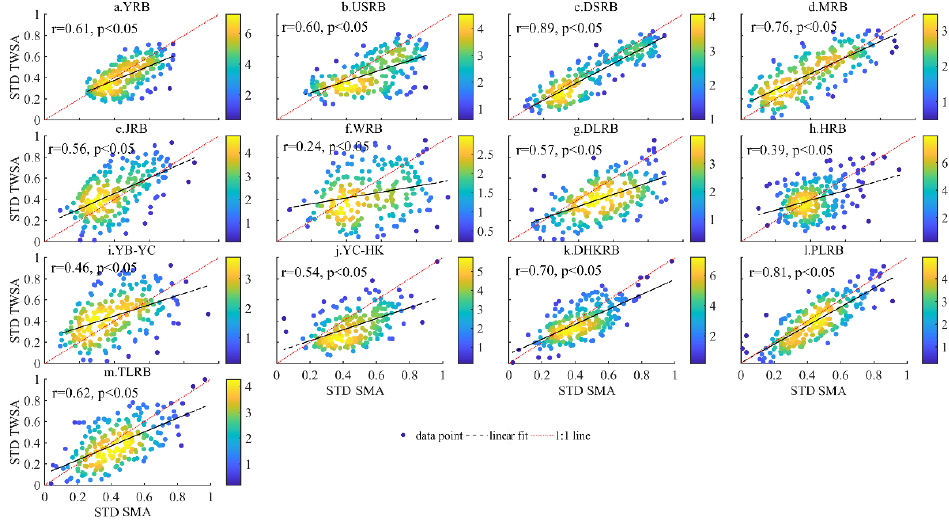
Figure 10. Kernel plot between standard GRACE-TWSA and VIC-GWSA in the sub-basins of YRB during April 2002–December 2019.